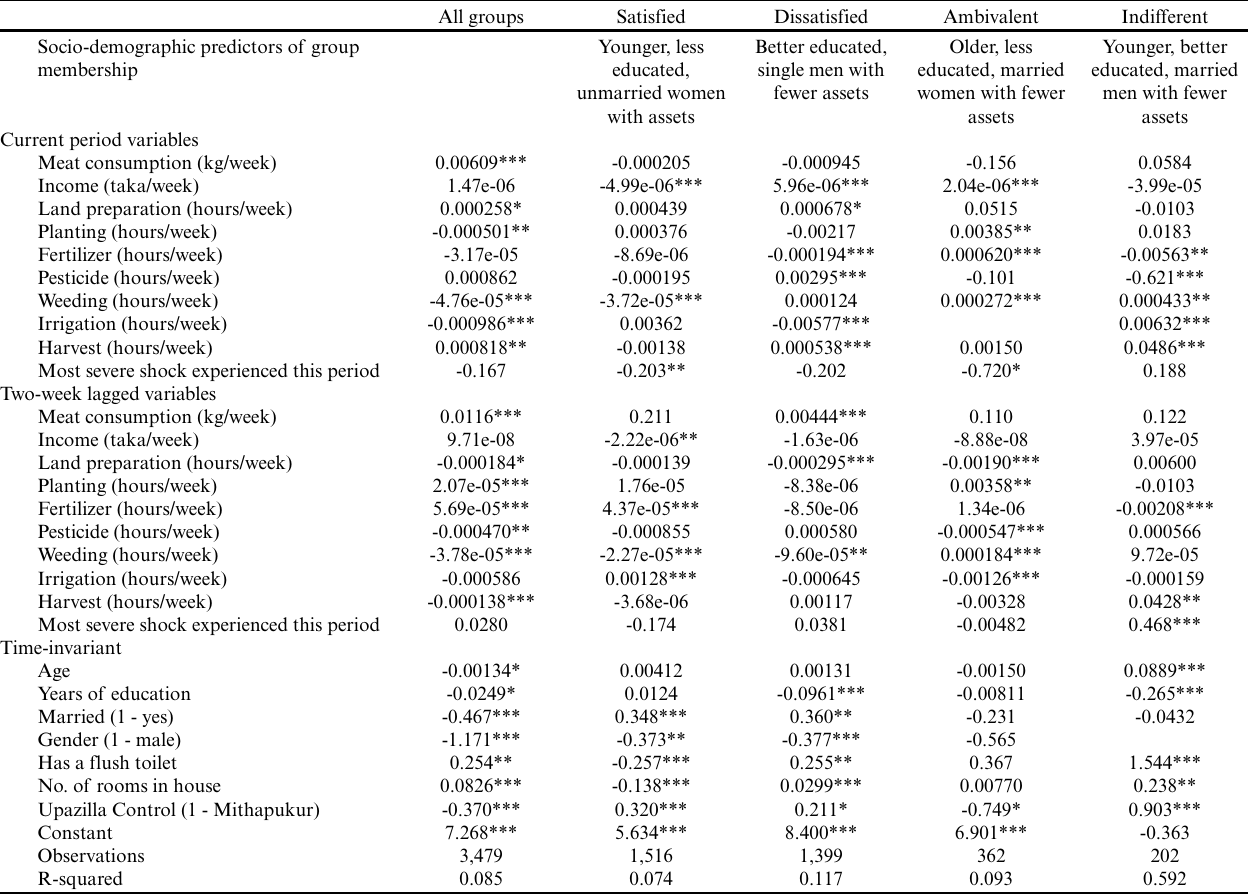
Table 3 . Results of the regression model predicting reported life satisfaction based on socio-demographics, wealth level, and agricultural activity for the whole sample, and disaggregated by satisfaction groups. For shocks: 0 – none; 1 – low impact; 2 – medium impact; 3